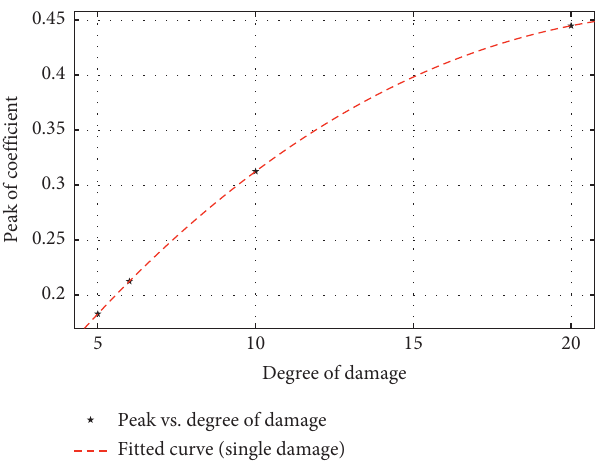
Figure 25: Fitted curve for single damage.